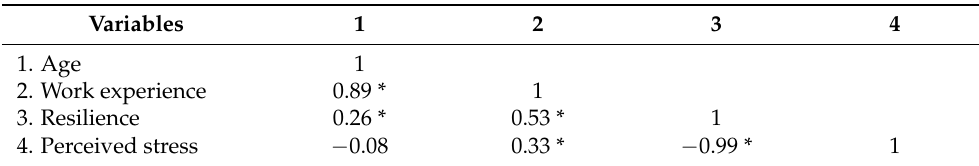
Table 3. Pearson correlation coefficient results for age, work experience, resilience, and per- ceived